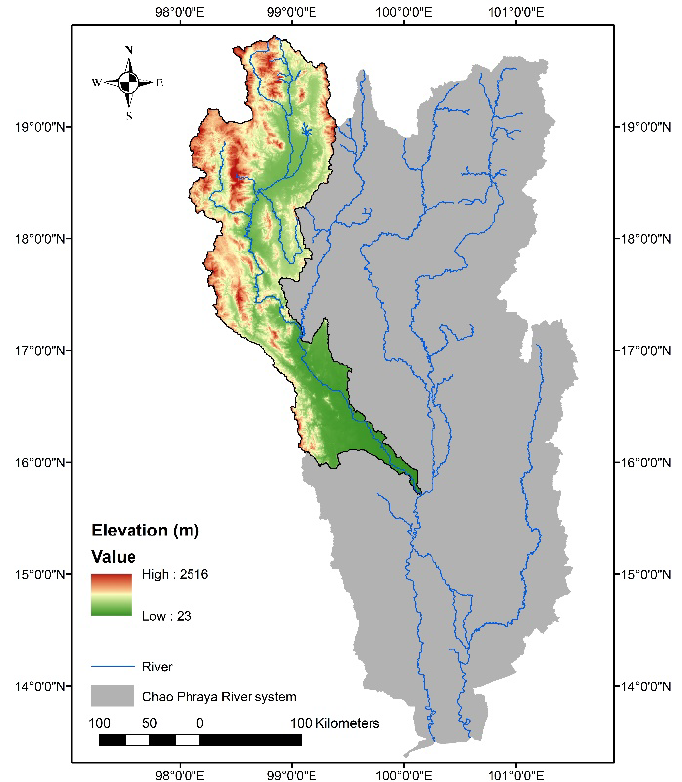
Figure 1. Ping River Basin.